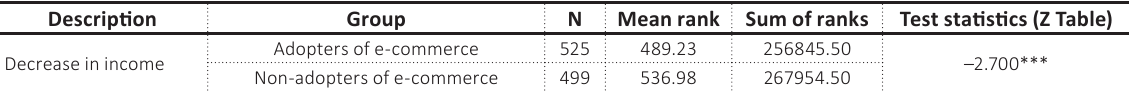
Table 3. Mann-Whitney test results for decrease in income of small